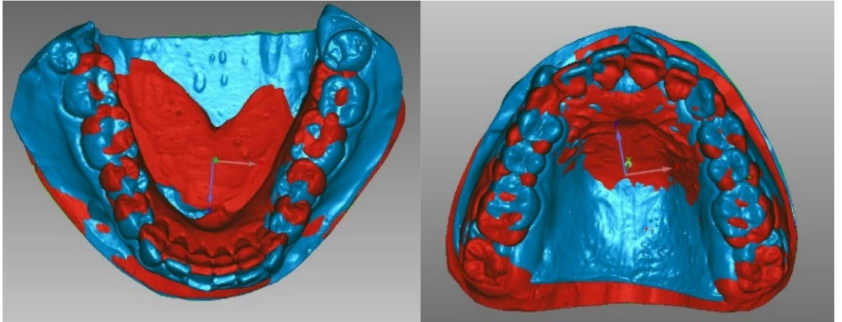
Figure 9. Maxillary and mandibular superimpositions of pretreatment (blue) and post-treatment (red) digital dental models of a patient showing expansion of the dental arch.